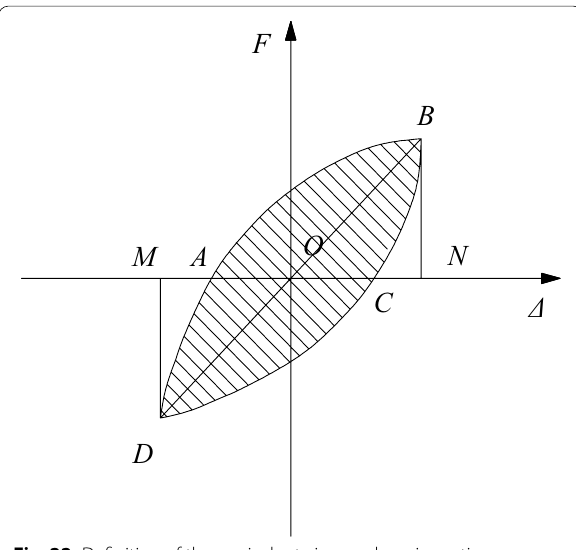
Fig. 22 Definition of the equivalent viscous damping ratio.